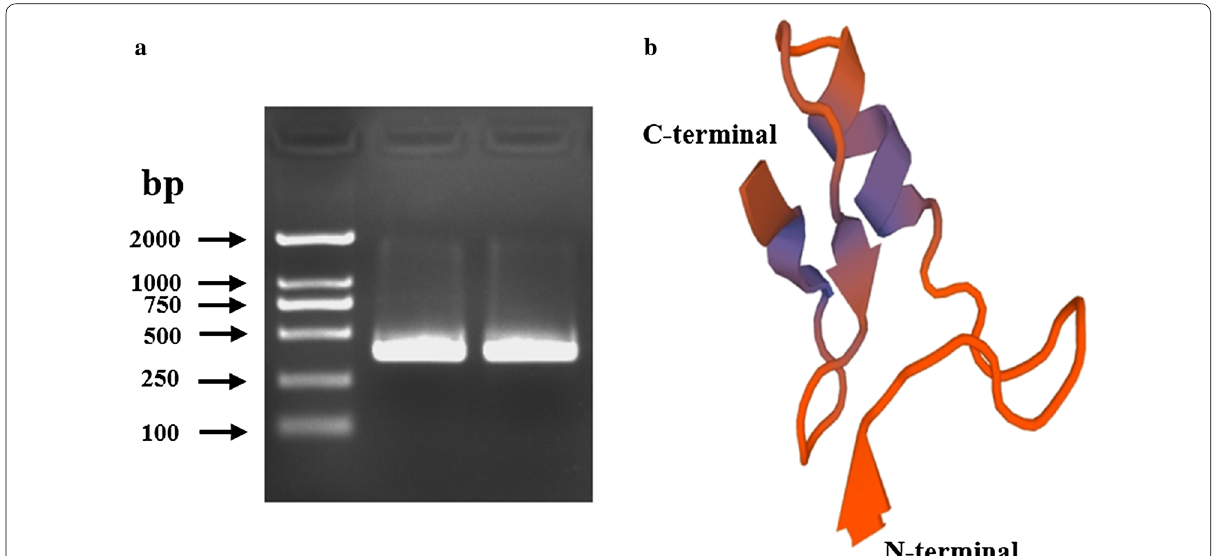
Fig. 1 Electrophoresis image of PCR ( a ) and predicted tertiary structure of protein encoded by BdPho ( b )